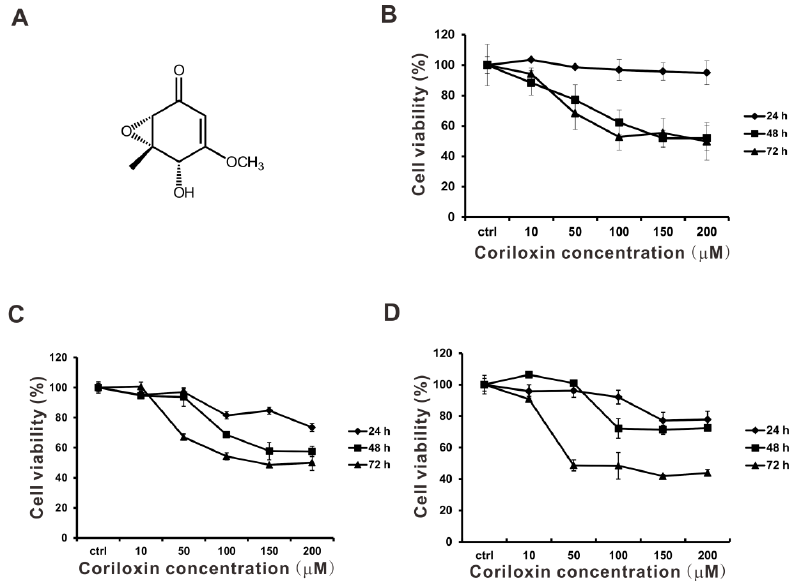
Figure 1. Influence of coriloxin on BEAS2B, A549, and CL1-5 cell viability. ( A ) Chemical composition of the isolated coriloxin. Following treatment with various concentrations of coriloxin, ( B ) BEAS2B, ( C ) A549, and ( D ) CL1-5 cells were subjected to the MTT assay. Results shown are percentages of the solvent control group (0.01% DMSO). These results are representative of two independent experiments performed, at least, in triplicate. Data are expressed as mean ±SD.